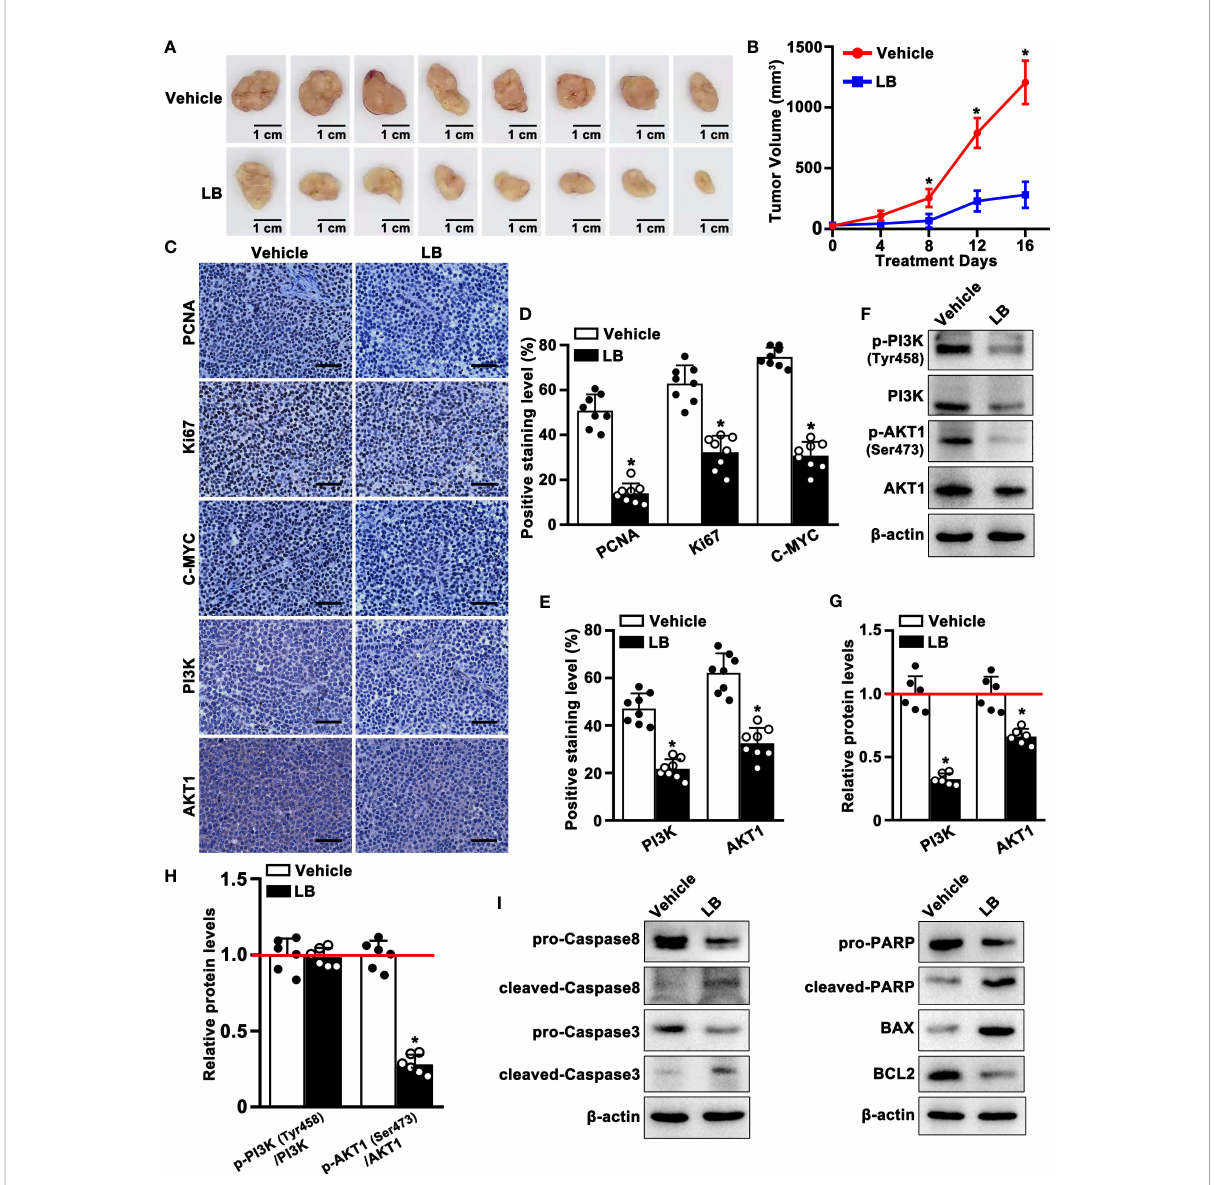
FIGURE 8 LB inhibited the proliferation and induced apoptosis of A549 xenograft tumors. BALB/c nude mice were injected subcutaneously with A549 cells, followed by injection of LB (10 mg/kg/day) or vehicle for 16 days. (A) Photographs showing xenograft tumors after injection of LB or vehicle for 16 days. (B) Tumor growth curve in vehicle group and LB group (n=8 each). (C – E) Immunohistochemical analyses of PCNA, Ki67, C- MYC, PI3K and AKT1 protein expression in tumor tissues of mice treated with LB and vehicle (n=8 each). The bar represents 50 m m. (F – H) Western blotting analyses of p-PI3K (Tyr458), PI3K, p-AKT1 (Ser473) and AKT1 protein expression levels in xenograft tumors of mice treated with LB (10 mg/kg/day) or vehicle (n=6 each). (I) Western blotting analyses of Caspase8, Caspase3, PARP, BCL2, and BAX protein expression levels in xenograft tumors of mice treated with LB or vehicle. Data are expressed as mean ± SEM. *P<